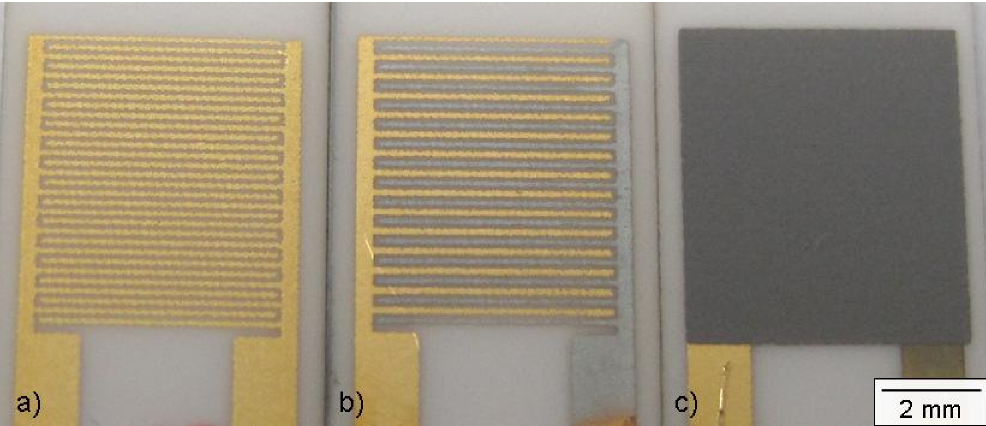
Figure 2. (a) Screen-printed and sintered interdigital gold electrodes; (b) One selectively electroplated Cr-covered gold electrode; (c) Entire setup with screen-printed